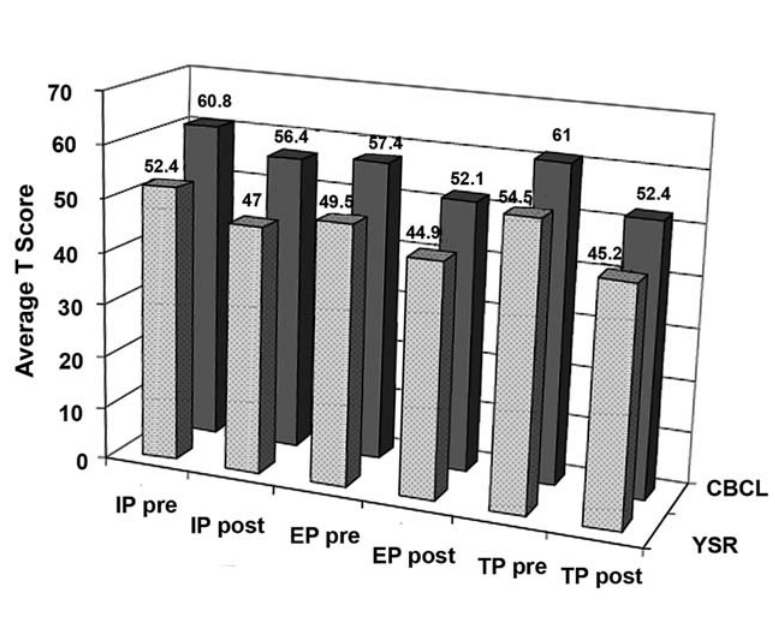
Figure 2 – Adolescent average T scores obtained by parental (CBCL) and self (YSR) reports; pre and post treatment data. IP = Internal- izing Problems Scale; EP = Externalizing Problems Scale; TP = Total Problems